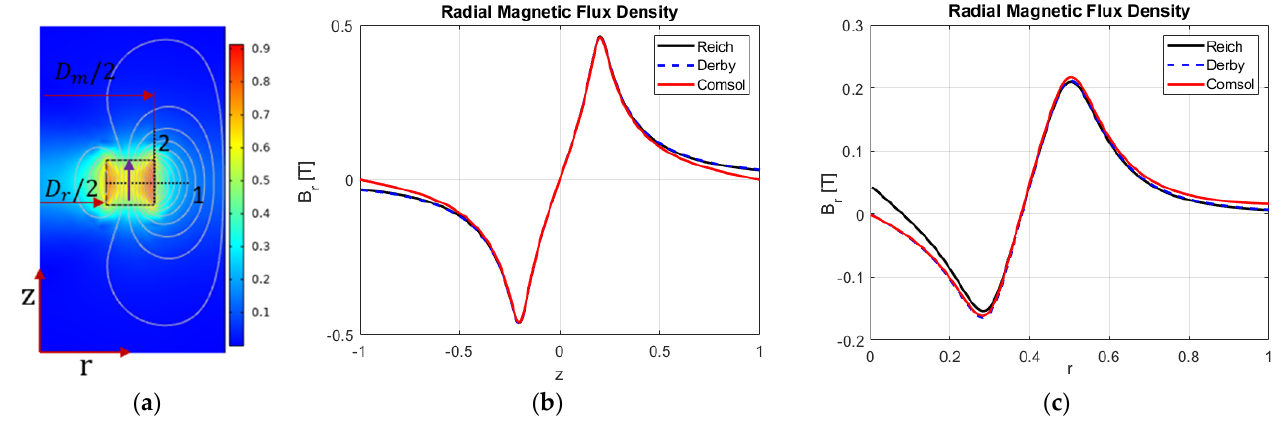
Figure 6. Validation of the EC damper model against literature models [16,17], in terms of the radial magnetic flux density: ( a ) axisymmetric magnetic flux distribution across the PM: the solid purple arrow indicates the magnetization direction; ( b ) along positive direction 1; ( c ) along positive direction 2 in the PM.